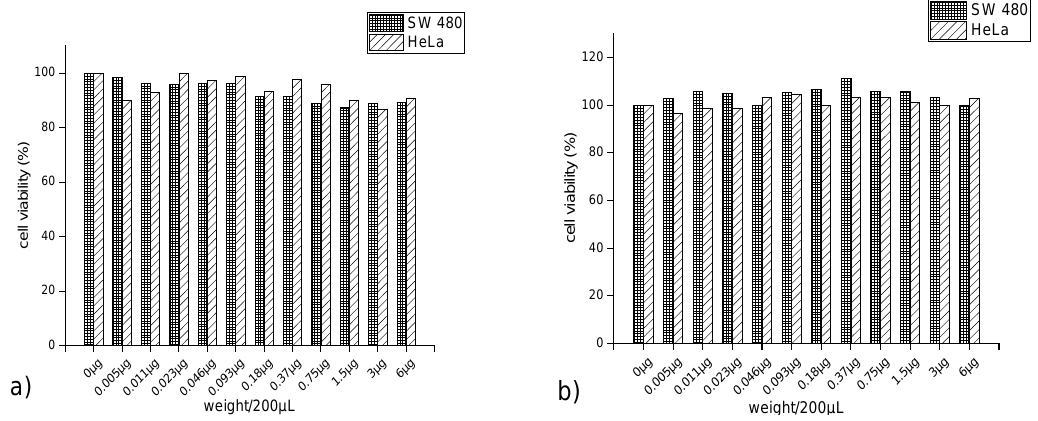
Figure 13. In vitro cytotoxicity of ( a ) JC-Fe 3 O 4 NPs and ( b ) CT-Fe 3 O 4 NPs against SW480 and HeLa cells assessed by MTT assays. Cytotoxicity is given as the percentage of viable cells remaining after treatment.